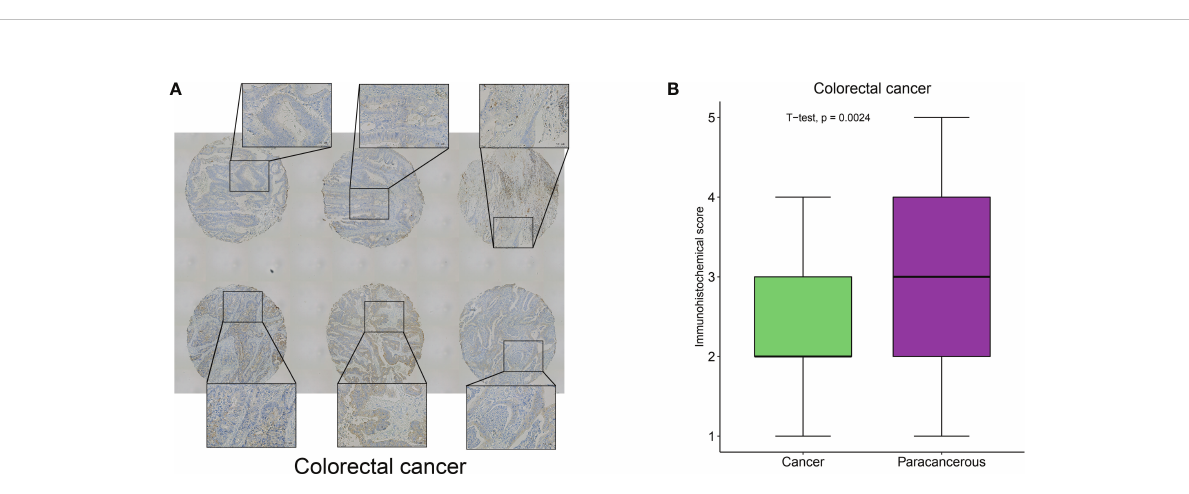
FIGURE 12 ITGA5 was signi fi cantly low expressed in colorectal cancers by Immunohistochemical validation. (A) Representative images of immunohistochemical detection of ITGA5 expression in colorectal cancer. (B) Statistical results of ITGA5 expression.